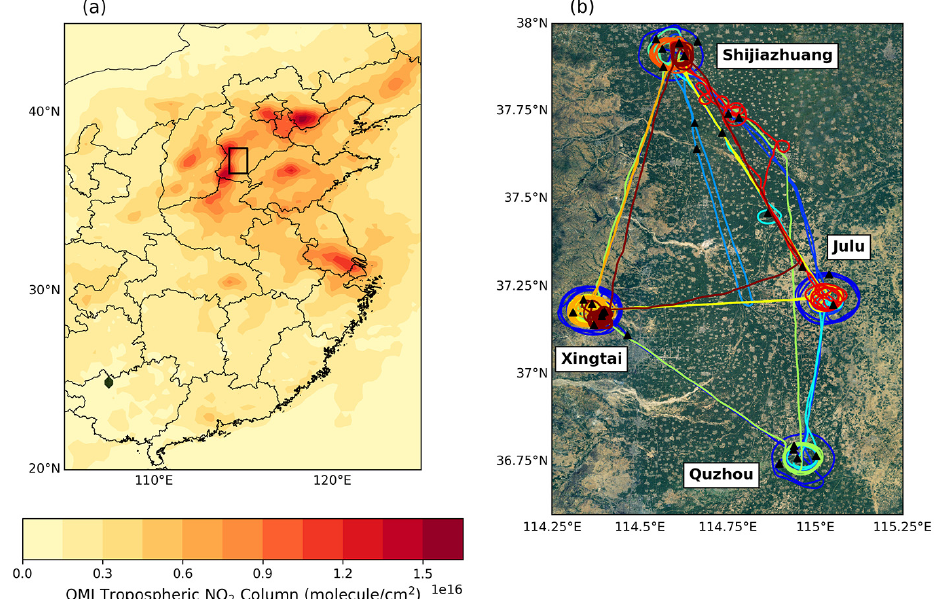
Figure 1. (a) May and June 2016 OMI tropospheric column NO 2 from the NASA Goddard Earth Sciences Data and Information Services Center. The North China Plain is clearly seen in the center with high column NO 2 concentrations; the black rectangle indicates the ARIAs campaign domain and corresponds to the region shown in panel (b) . (b) Map of 11 ARIAs flight tracks (colored by flight number) and location of VOC samples (black triangles). The background map is provided by Esri ©